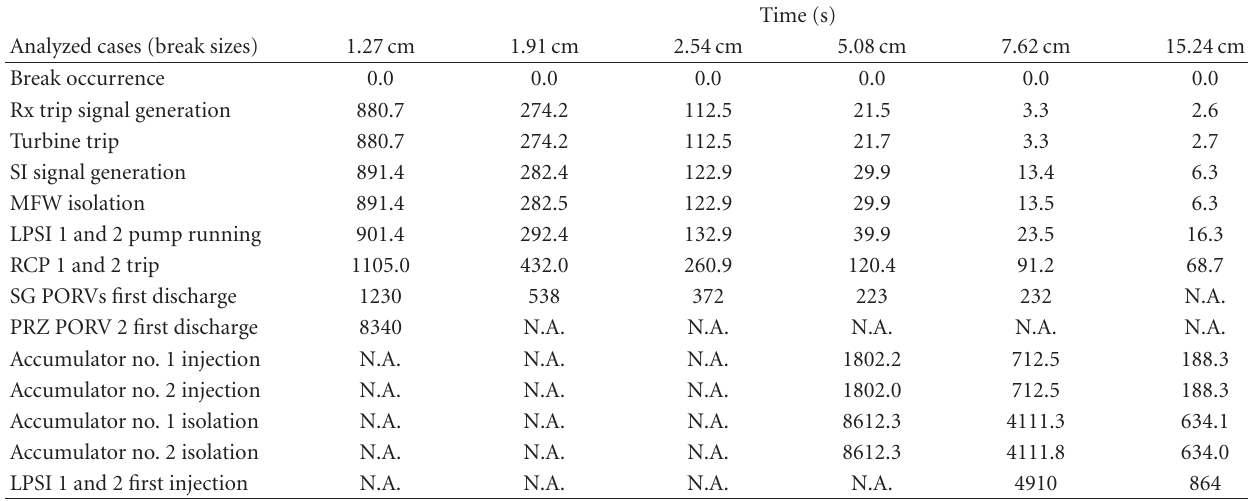
Table 1: Sequence of main events for LOCA